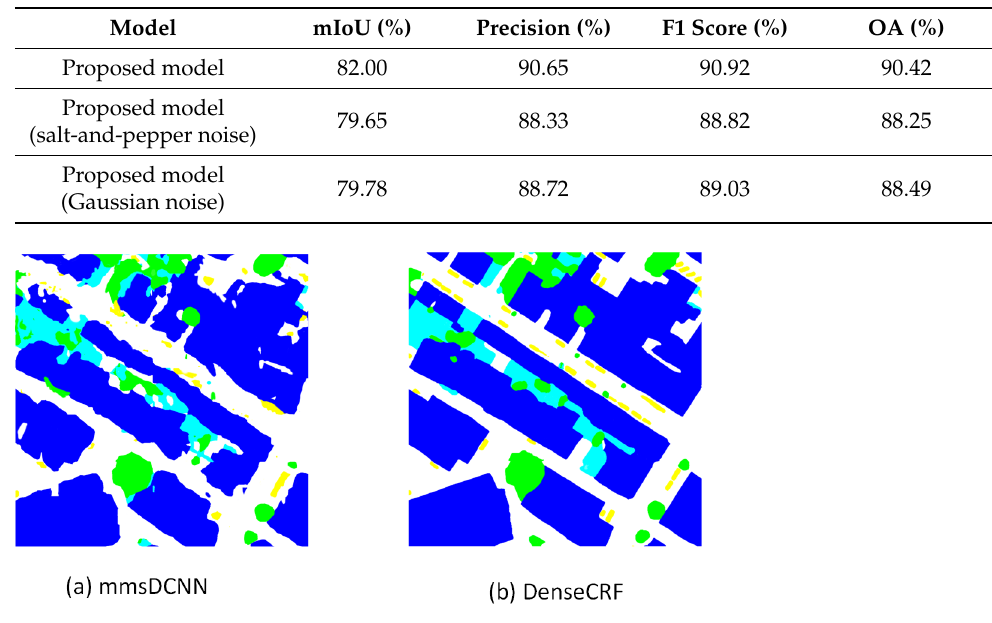
Table 8. Results on the damaged Potsdam testing set.